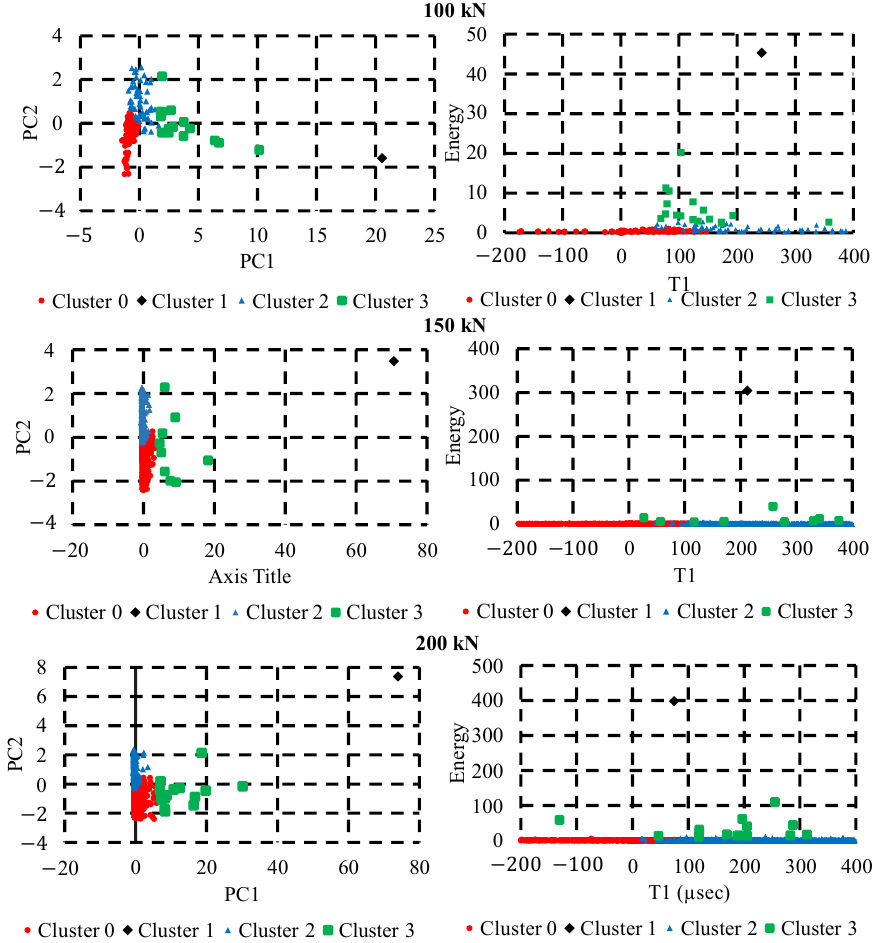
Figure 10. Clustering results for all three experiments; Cluster with respect to principal components (left side image); Cluster with respect to energy and rise time(right side image).